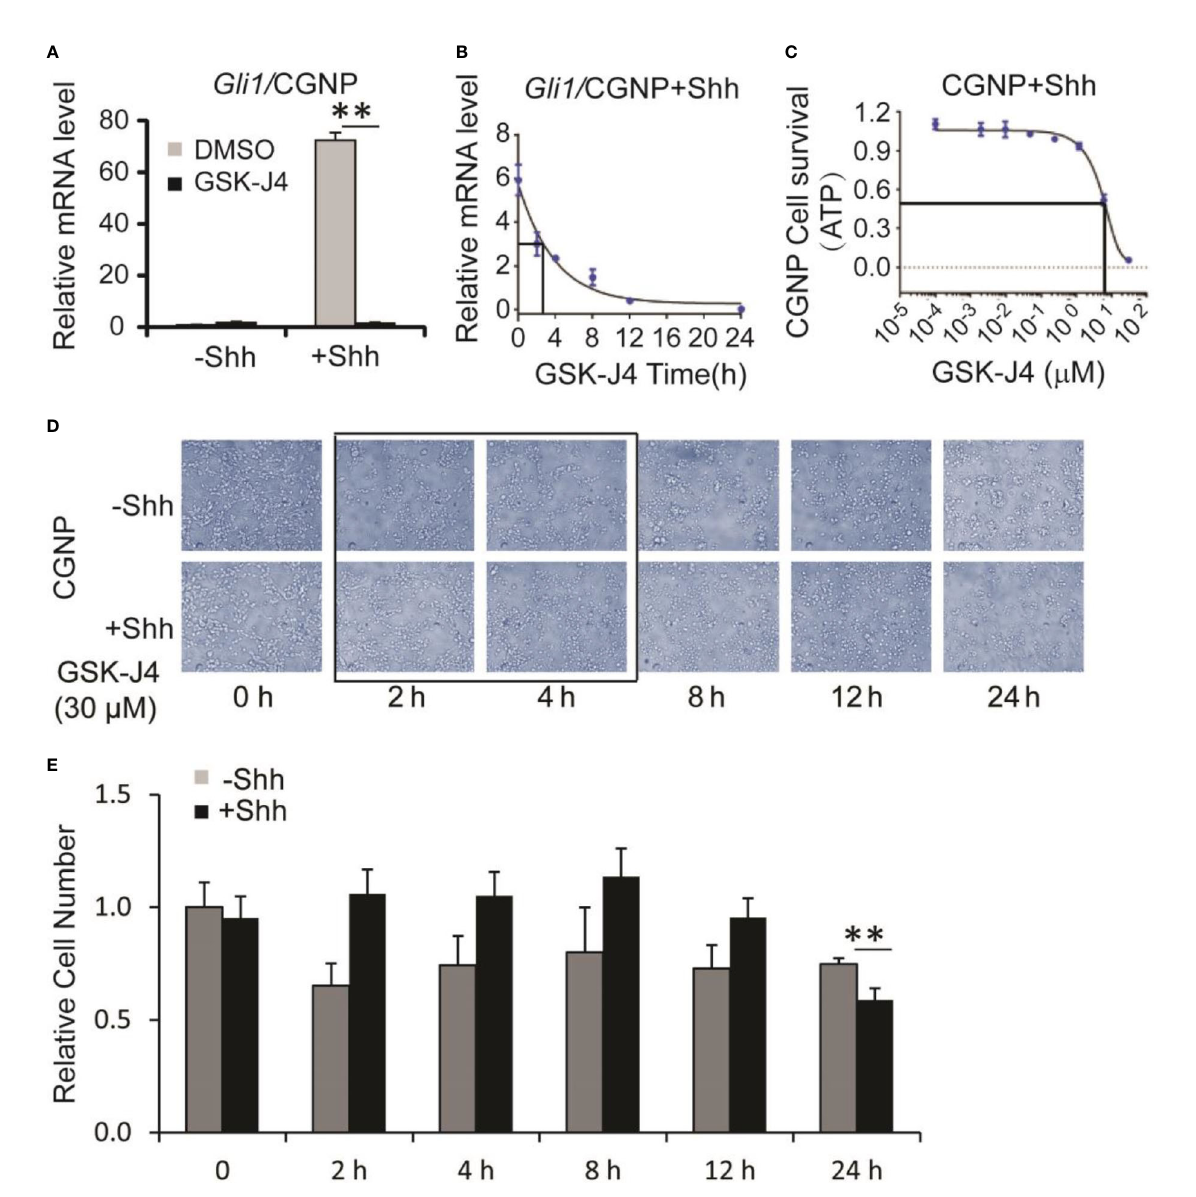
FIGURE 2 Shh signaling and growth of CGNP cells are inhibited by GSK-J4. (A) GSK-J4 decreases Shh-induced Gli1 expression in P4 CGNP cells. (B) Time course of GSK-J4 effect on Gli1 expression in P4 CGNP cells. (C) Dose dependent survival of CGNP cells after the treatment of GSK-J4 shown by ATP assay. (D, E) Cell performances after the treatment of GSK-J4 for indicated time courses and doses. The cells with frame have signi fi cant changes after treatment with GSK-J4. Signi fi cance determined using t -test. ** p <